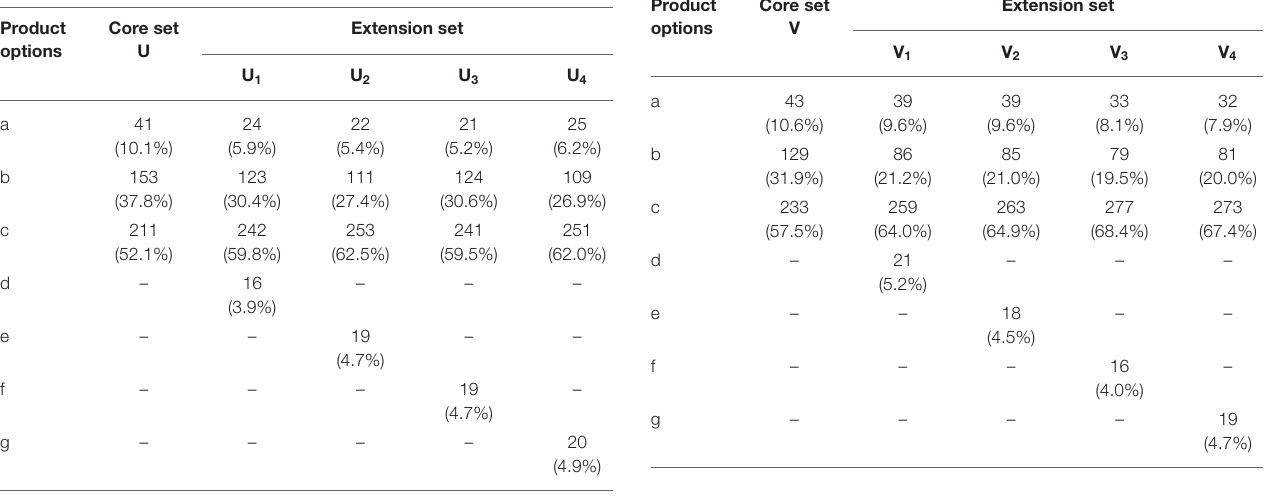
TABLE 4 | The absolute purchase share in the yellow-feathered broilers experiment.